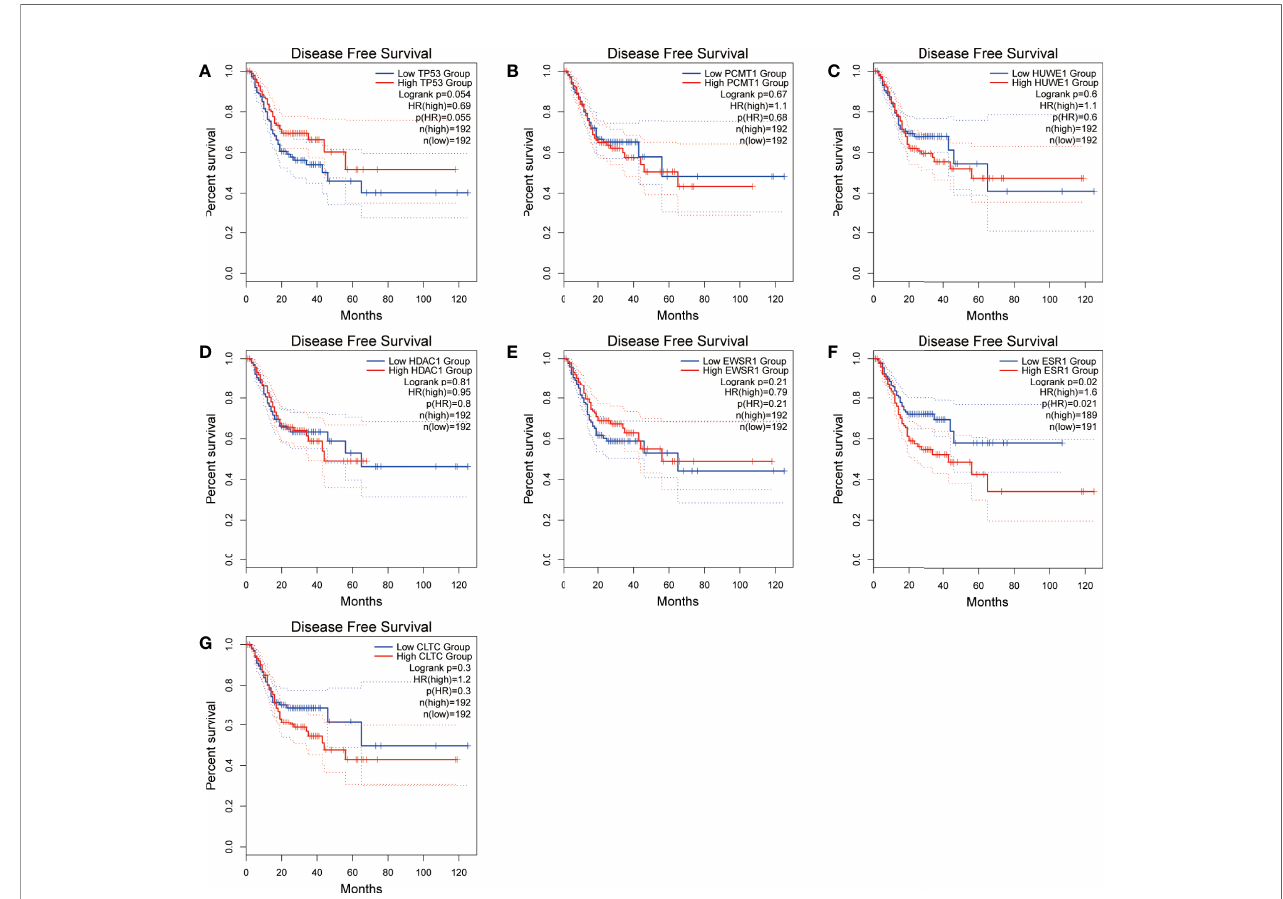
FIGURE 10 | Disease-free survival (DFS) analysis of the seven hub genes in STAD patients from the GEPIA2 database. (A) Survival analysis for TP53 in STAD. (B) Survival analysis for PCMT1 in STAD. (C) Survival analysis for HUWE1 in STAD. (D) Survival analysis for HDAC1 in STAD. (E) Survival analysis for EWS1 in STAD. (F) Survival analysis for ESR1 in STAD. (G) Survival analysis for CLTC in STAD. The patients were strati fi ed into a high-level group (red) and a low-level group (blue) according to the median expression of the gene. Log-rank P < 0.05 was considered to be a statistically signi fi cant